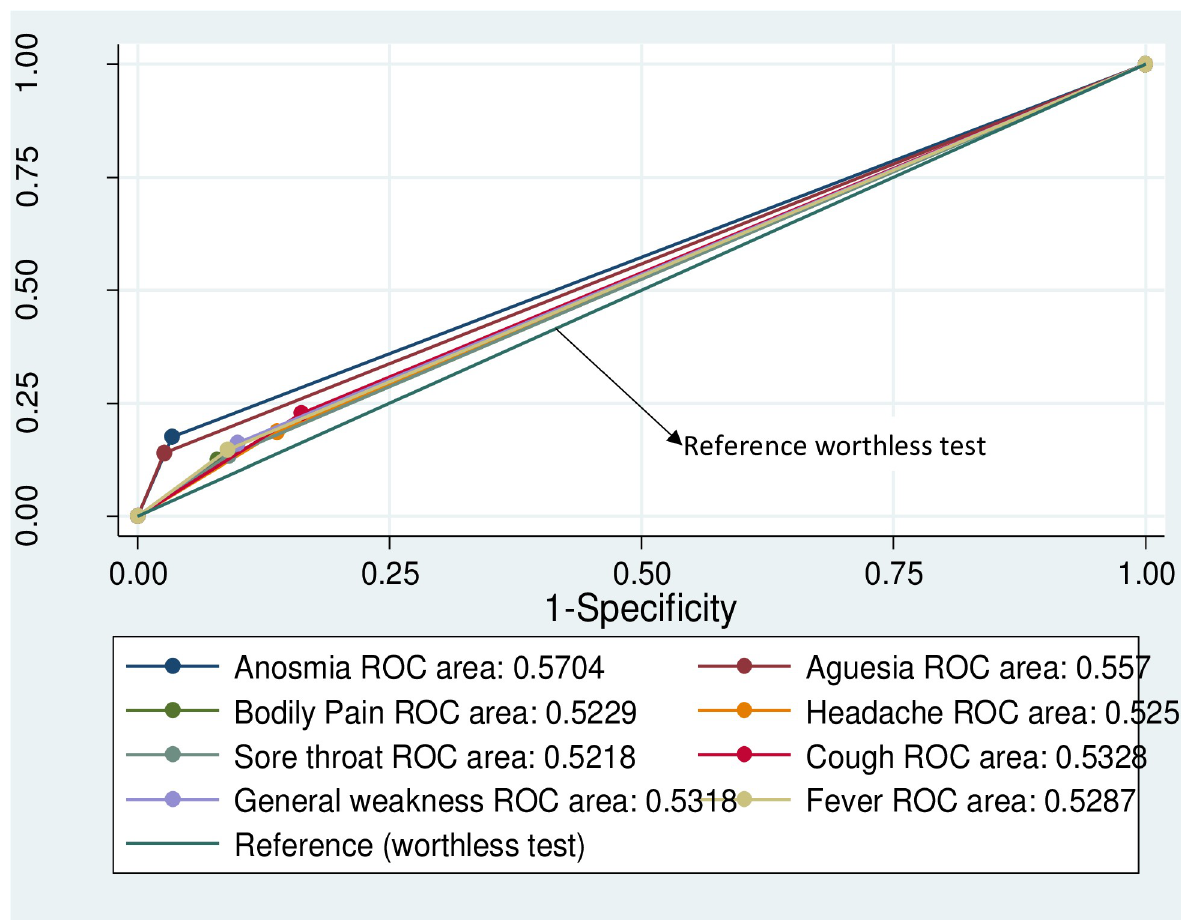
Fig 3. Receiver operator characteristic curve for independent classifiers associated with